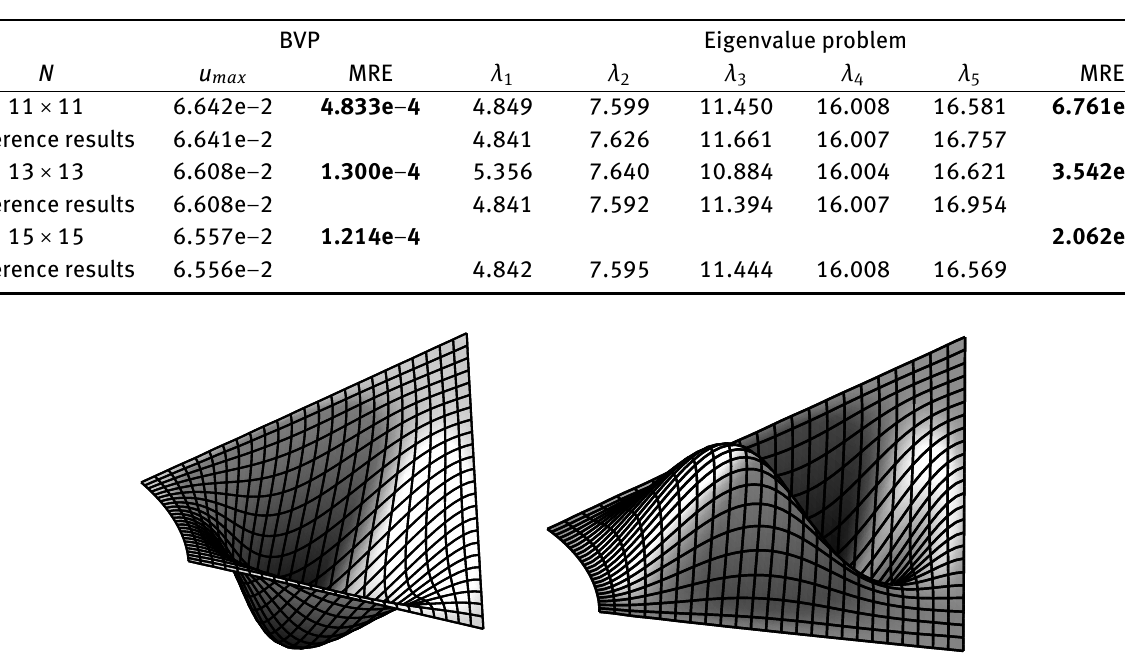
Table 4: The results from solving the biharmonic problems on the quarter section of the elliptical domain. The boundary conditions given by Eq. (29) implemented using strategy 2.